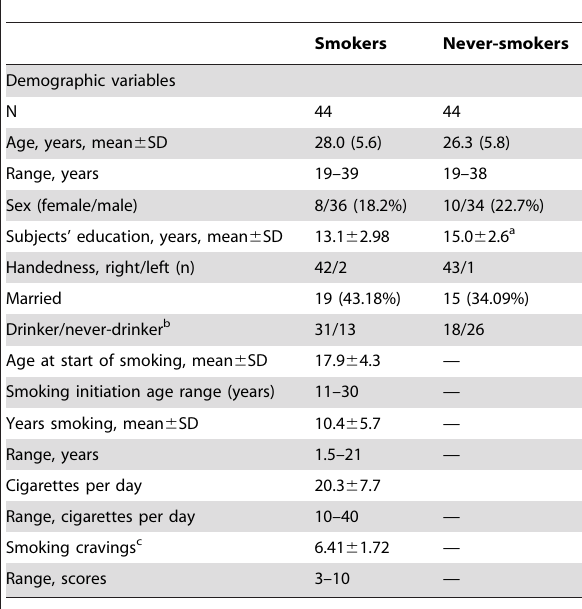
Table 1. Demographic characteristics of the smokers and never-smokers